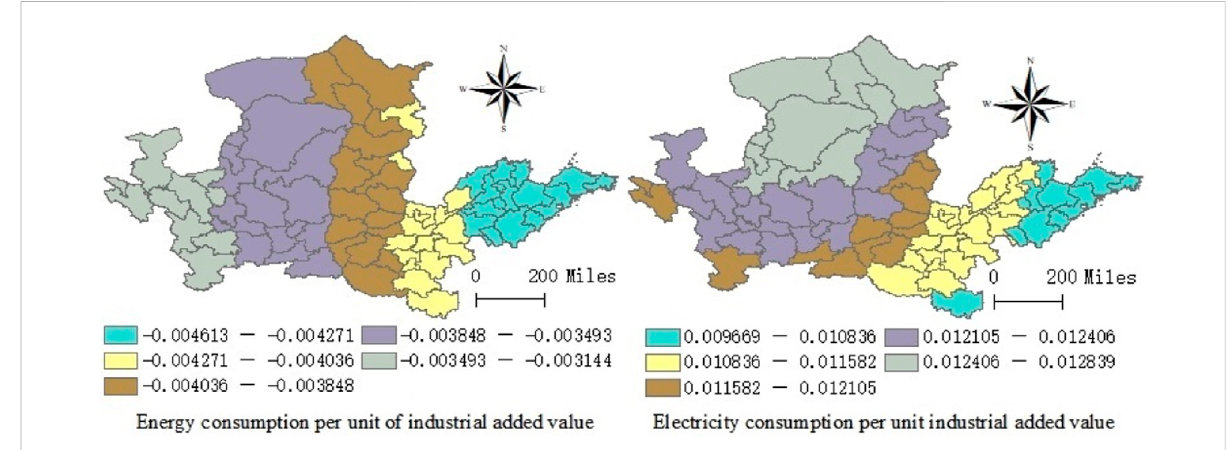
FIGURE 5 Spatial distribution of energy use degree estimation coef fi cients.